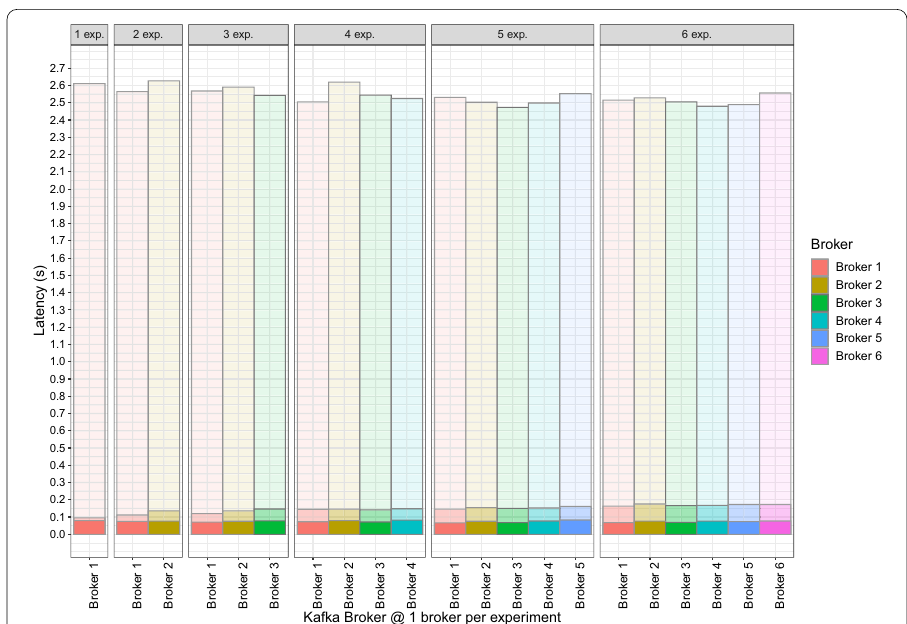
Fig. 10 Evolution of the three types of latency in multi‑broker